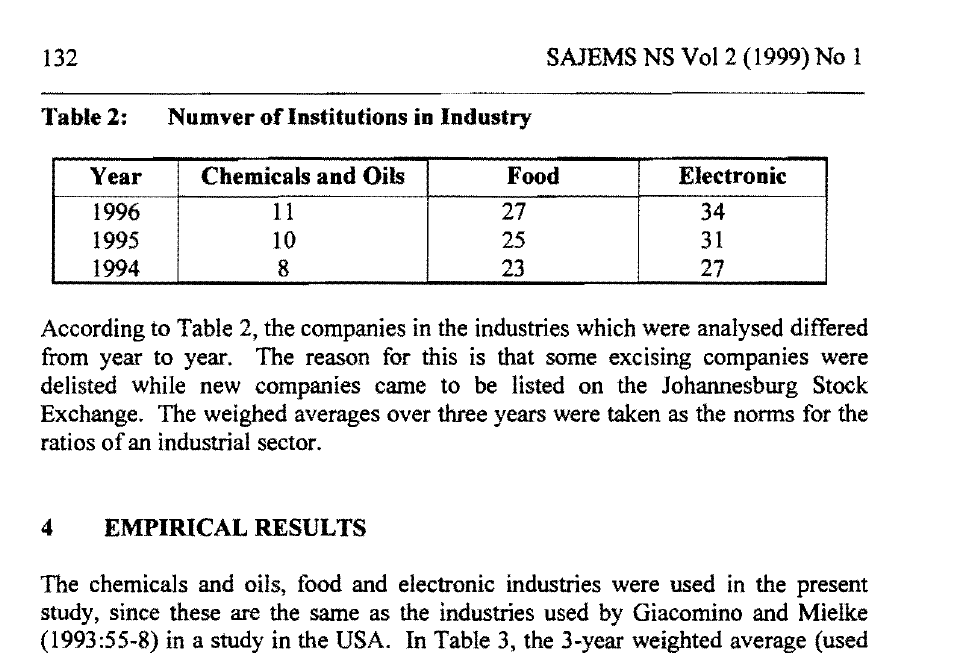
Norms for Ratios per